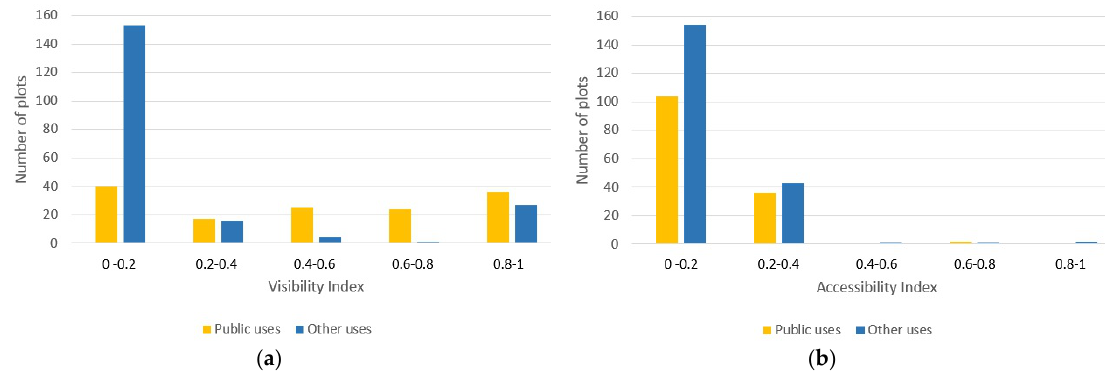
Figure 4. ( a ) Chart with relation between Visibility Index and land uses ((semi-)public or non-public) per plot; and ( b ) chart with relation between Accessibility Index and land uses ((semi-)public or non-public) per plot.